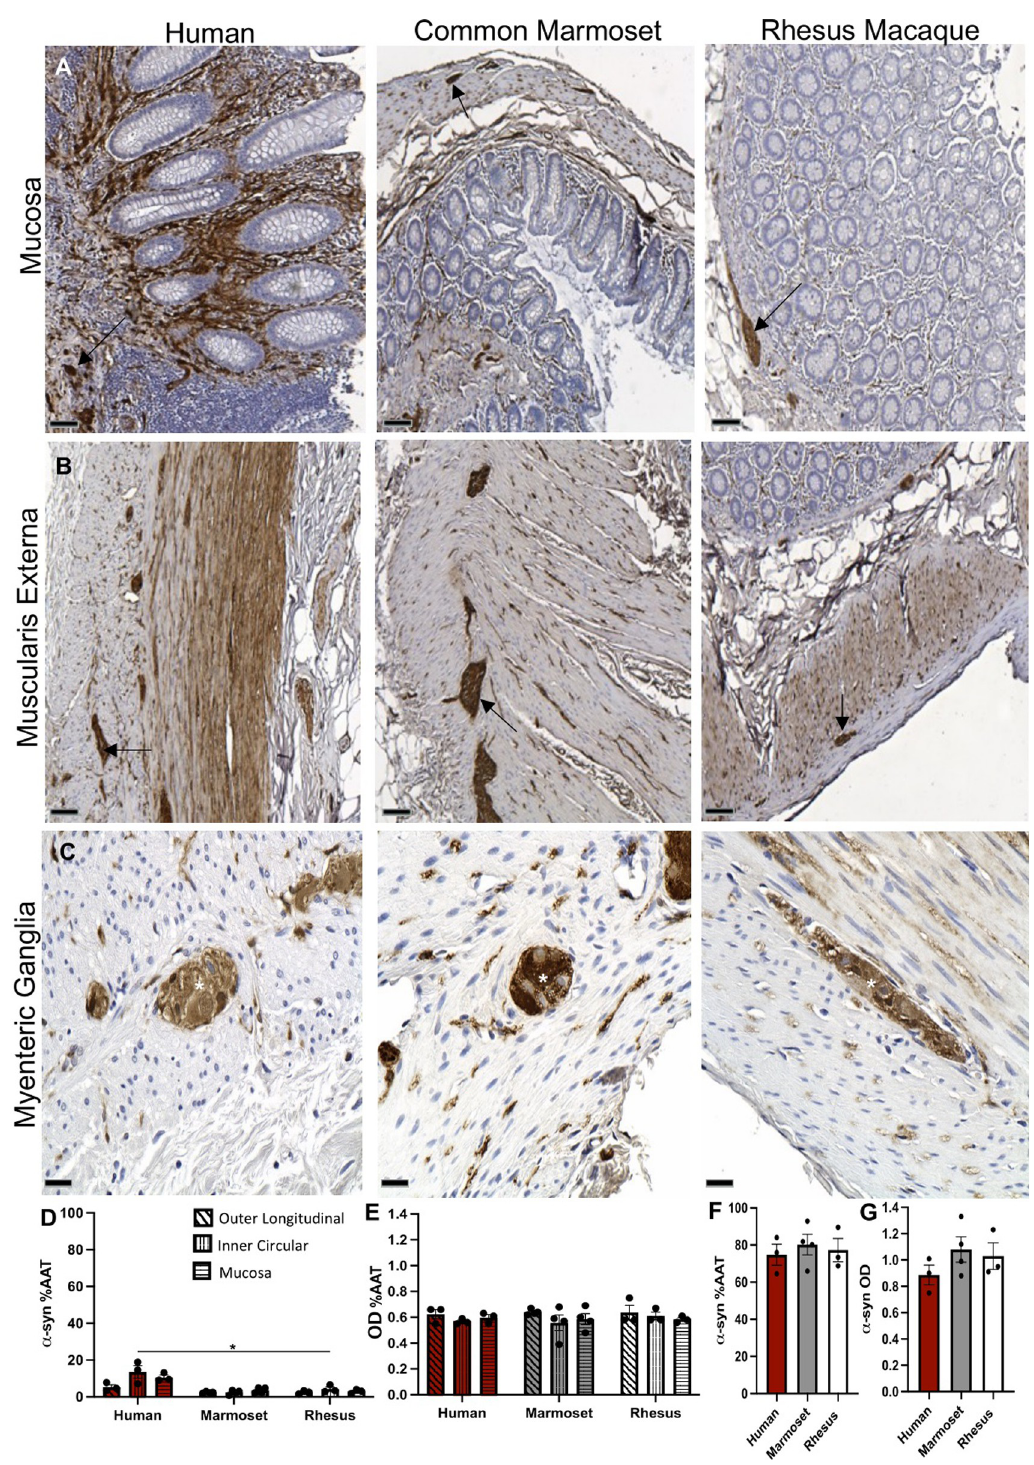
Fig 2. α -syn expression in the appendix/cecum across species. Images of α -syn-immunoreactivity (-ir) (brown) in the (A) mucosa (arrows), (B) muscularis externa (arrows) and (C) myenteric ganglia (asterisks) from human appendix, common marmoset and rhesus ceca tissue sections counterstained with hematoxylin (blue). Graphs (mean ± SEM) of α -syn-ir (D,E) in gastrointestinal layers and (F,G) myenteric ganglia across species. Scale bar; a, 100 μ m; b, 100 μ m; c, 25 μ m. Abbreviations: α -syn, alpha-synuclein; %AAT, percent area above threshold; OD, optical density. � p < 0.05.